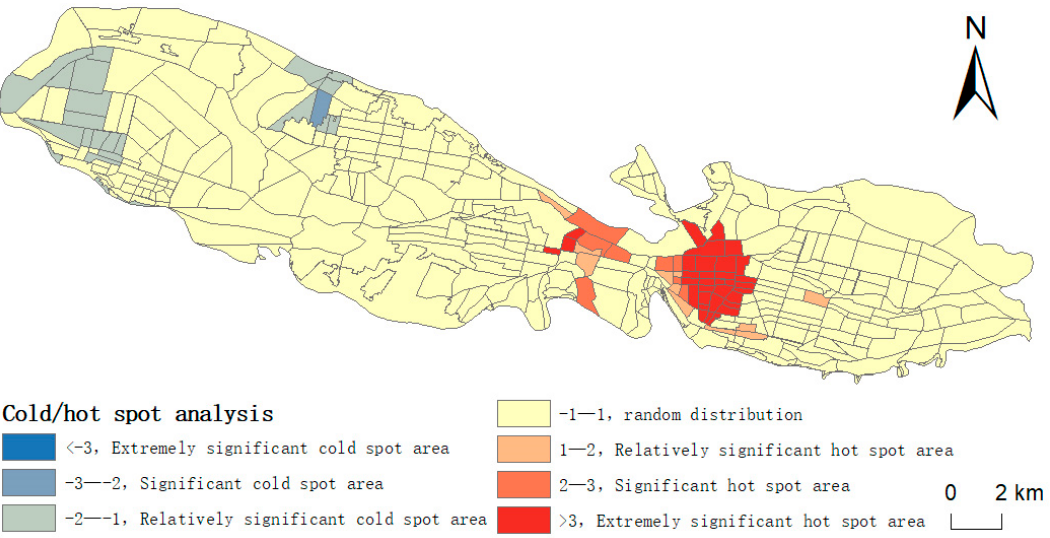
Figure 3. The distribution of cold and hot spots in the prevalence of hypertension in the main urban areas of Lanzhou in 2020.